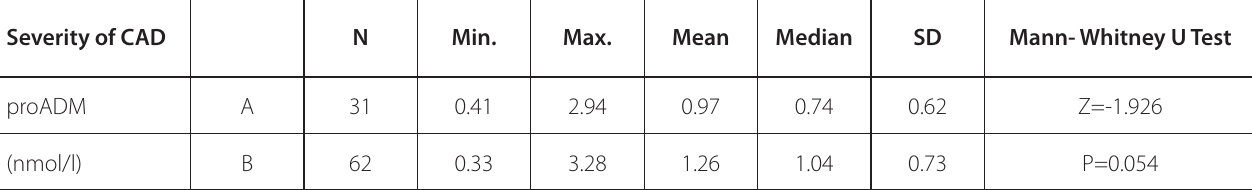
Table 2 . Comparison of patients with single and two-vessel CAD with patients with three-vessel CAD and CAD with LM disease in terms of